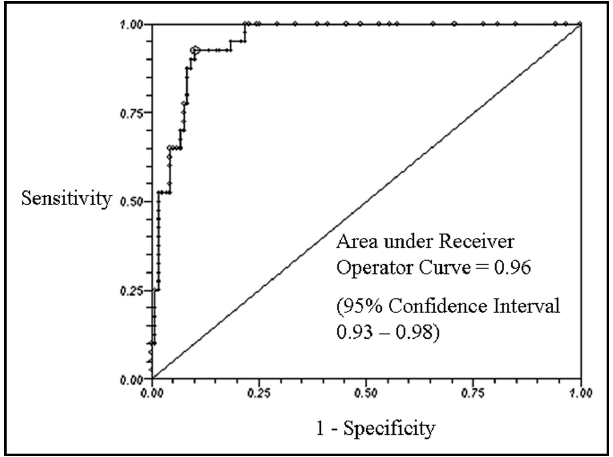
Figure 12. Receiver operator curve of NT–proBNP for diagnosis of carcinoid heart disease [6].